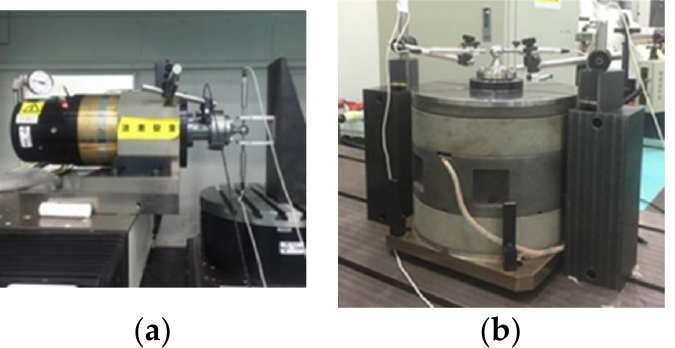
Figure 15. Test system and software developed ( a ) Test in the horizontal direction; ( b ) Test in the vertical direction.